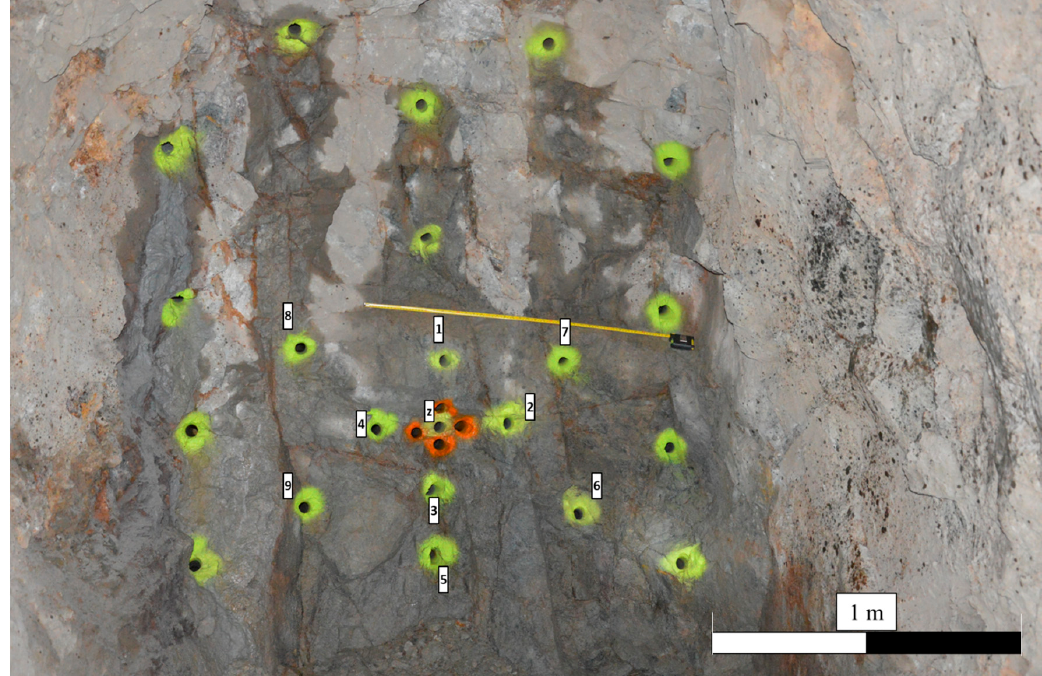
Figure 1. Drilling mesh on the blast face. Numbers indicate the firing sequence (“z” indicating zero). Light green: charged holes, orange: dummy holes. The metric scale is visible.